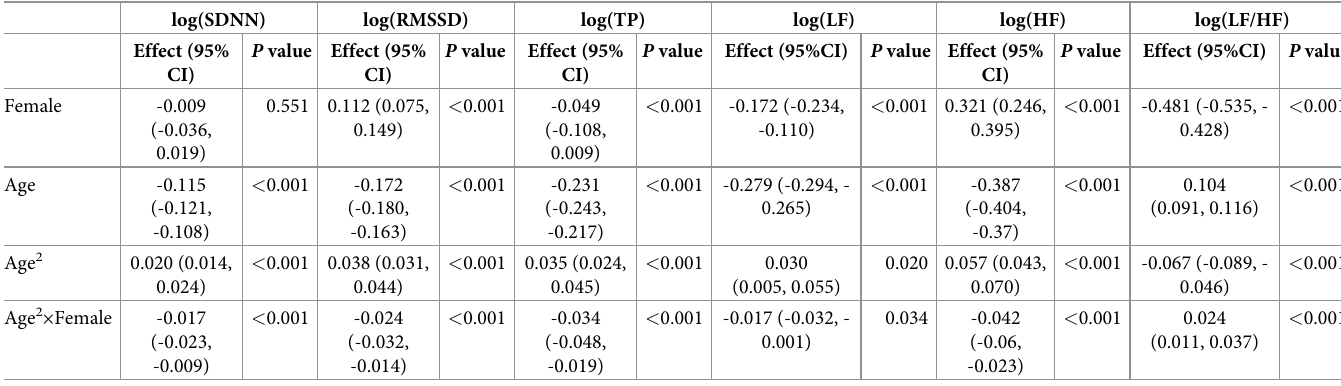
Table 2. Effect of sex and age a on